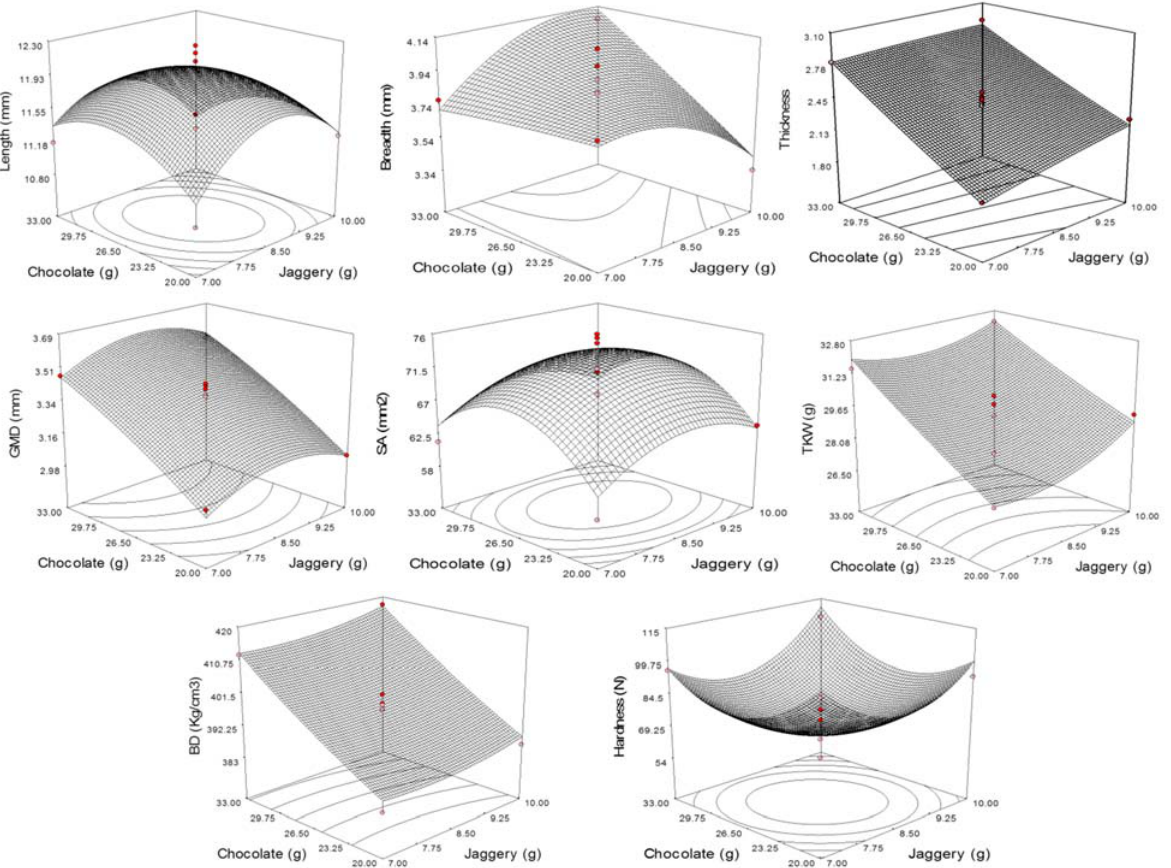
Figure 1. Physical and textural responses as affected by the levels of jaggery and chocolate.